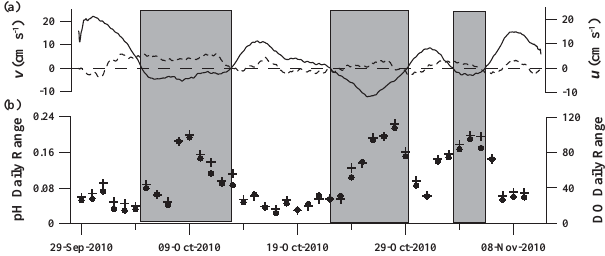
Fig. 4. (a) Mean alongshore current velocity ( v : solid) and mean cross-shore current velocity ( u : dotted) between 5 and 30m from the Del Mar buoy and (b) daily range in pH (circles) and dissolved oxygen (DO: crosses) from mooring A at 7m water depth. Grey- shaded rectangles indicate time periods when alongshore velocities are equatorward (negative). See Fig. 8 for corresponding time series of density, DO and